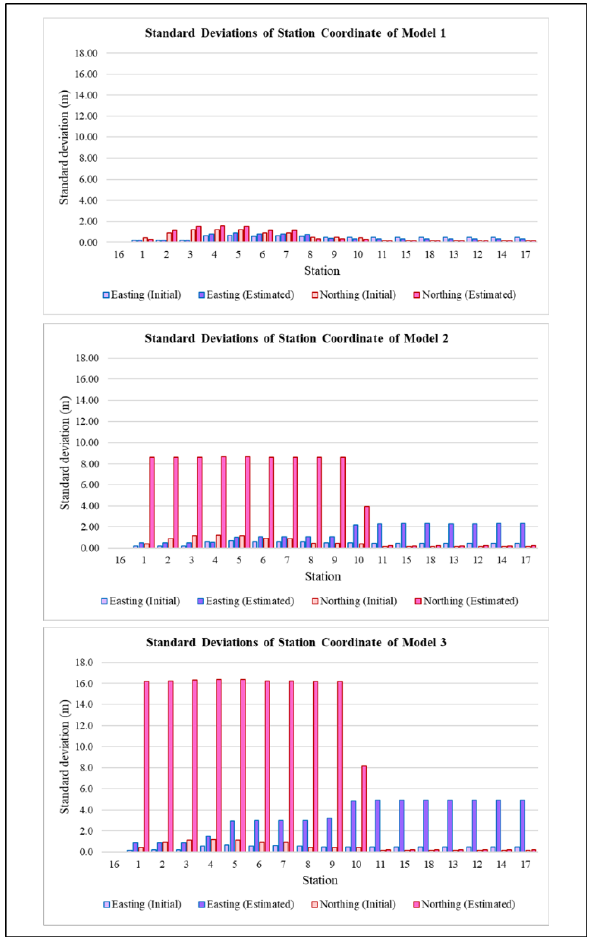
Figure 7. Estimated standard deviation of each station for Dataset 2 (chain, EDM, theodolite and total station)